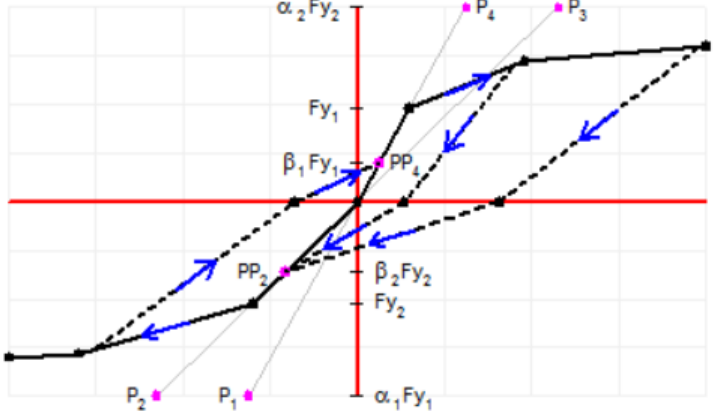
Figure 4. Multilinear plastic link with Pivot hysteretic model used for the nonlinear numerical analyses in SAP2000.